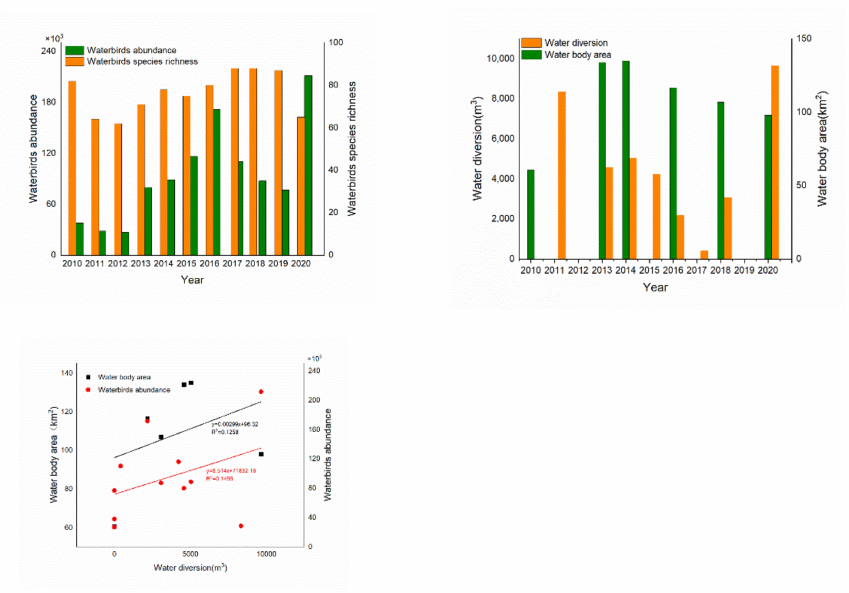
Figure 2. Annual dynamics of waterbird species and numbers in Xianghai Nature